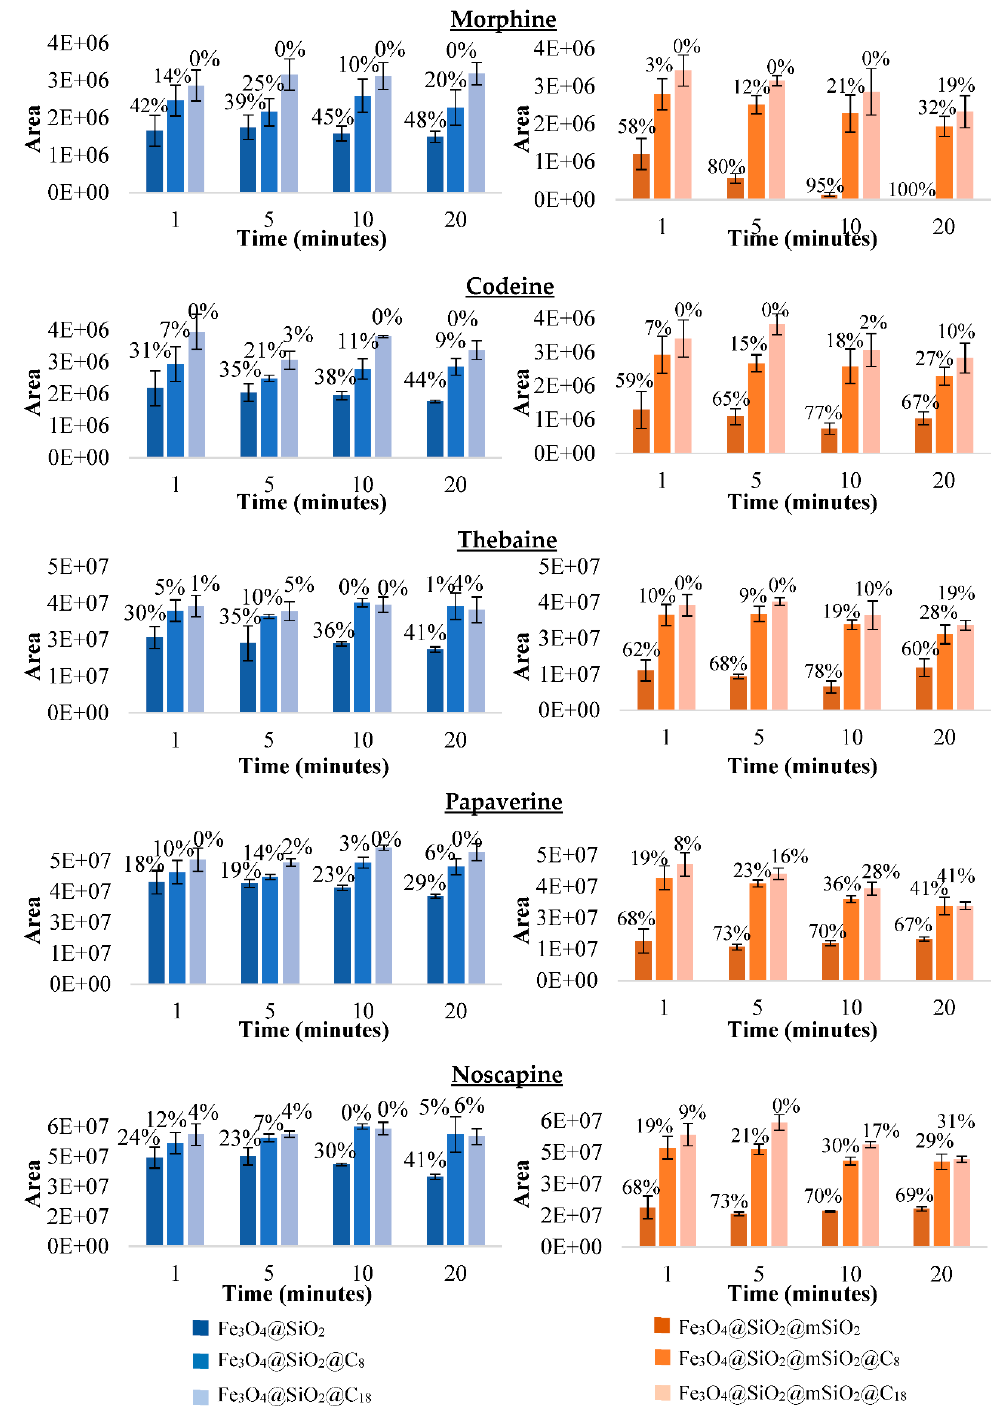
Figure 2. Areas of the supernatant with their respective percentages of adsorption (%) at different times with each of the three amorphous silica materials ( blue colour ) and mesostructured silica magnetic materials ( orange colour ) with methanol/water 50/50 ( v/v ) as the adsorption solvent.